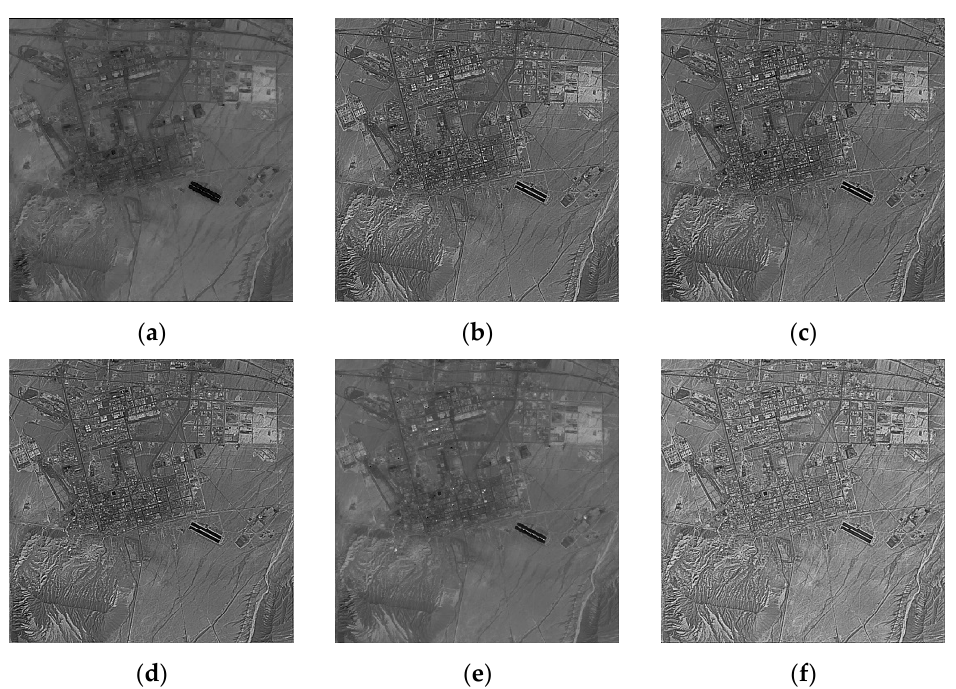
Figure 7. Enhanced image of data 1 by using our IDCP algorithm with: ( a ) Sobel; ( b ) Laplacian; ( c )